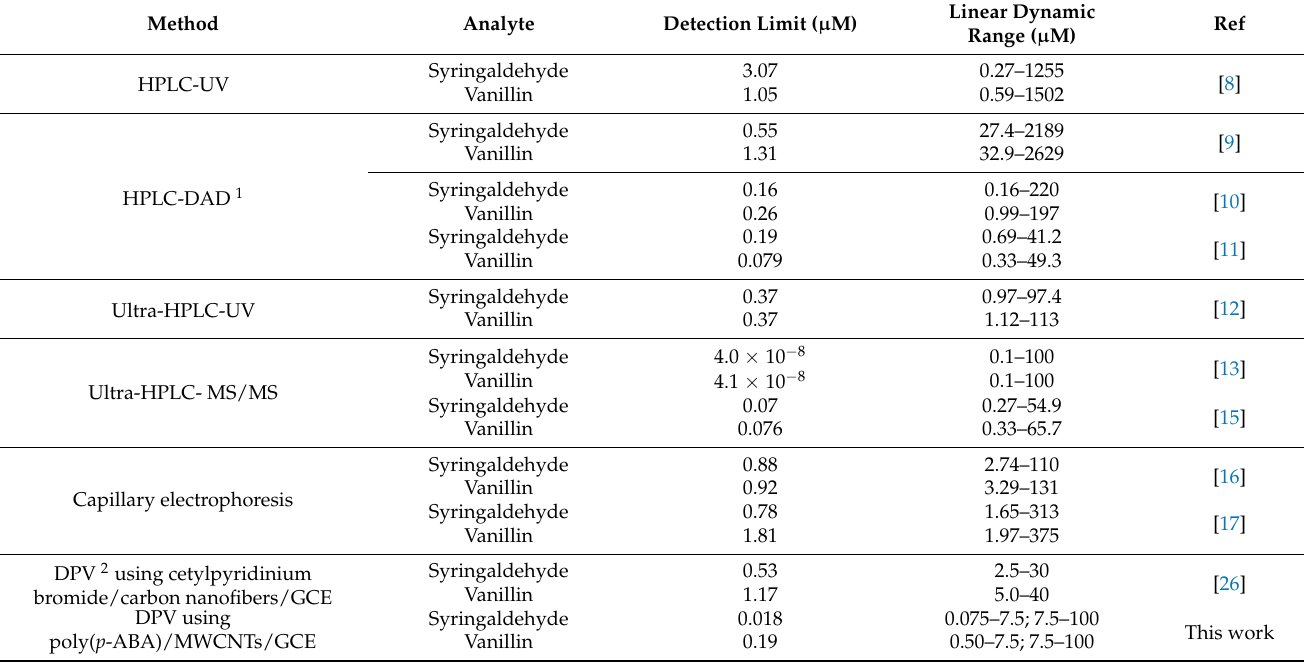
Table 5. Analytical characteristics of the simultaneous determination of aromatic aldehydes.